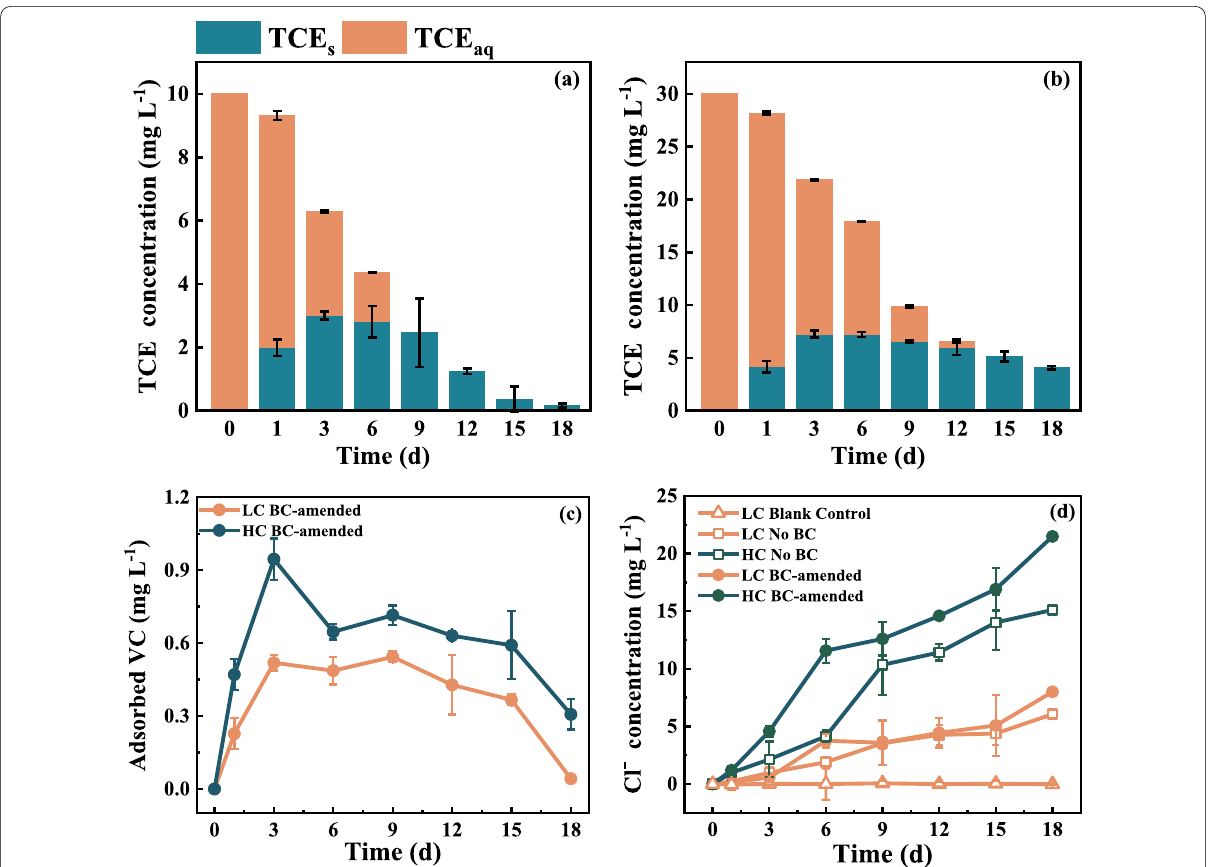
Fig. 2 Concentration change of the dechlorination-related products in the co-removal systems. a and b refer to the gradual decrease of TCE distributed in aqueous (TCE aq ) and biochar solid phase (TCE s ), respectively, in the low concentration (LC) and high concentration (HC) systems; Change curves of the adsorbed vinyl chloride (VC) on the biochar solid phase and the produced Cl − are shown in c and d ,